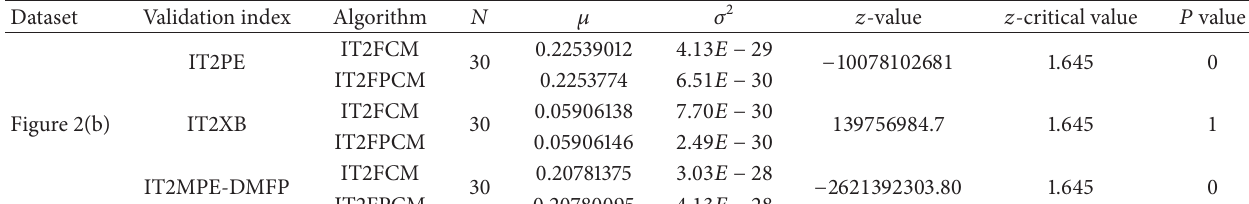
Table 32: Hypothesis test for IT2PE, IT2XB, and IT2MPE-DMFP indices of validation for Figure 2(b) clustering.